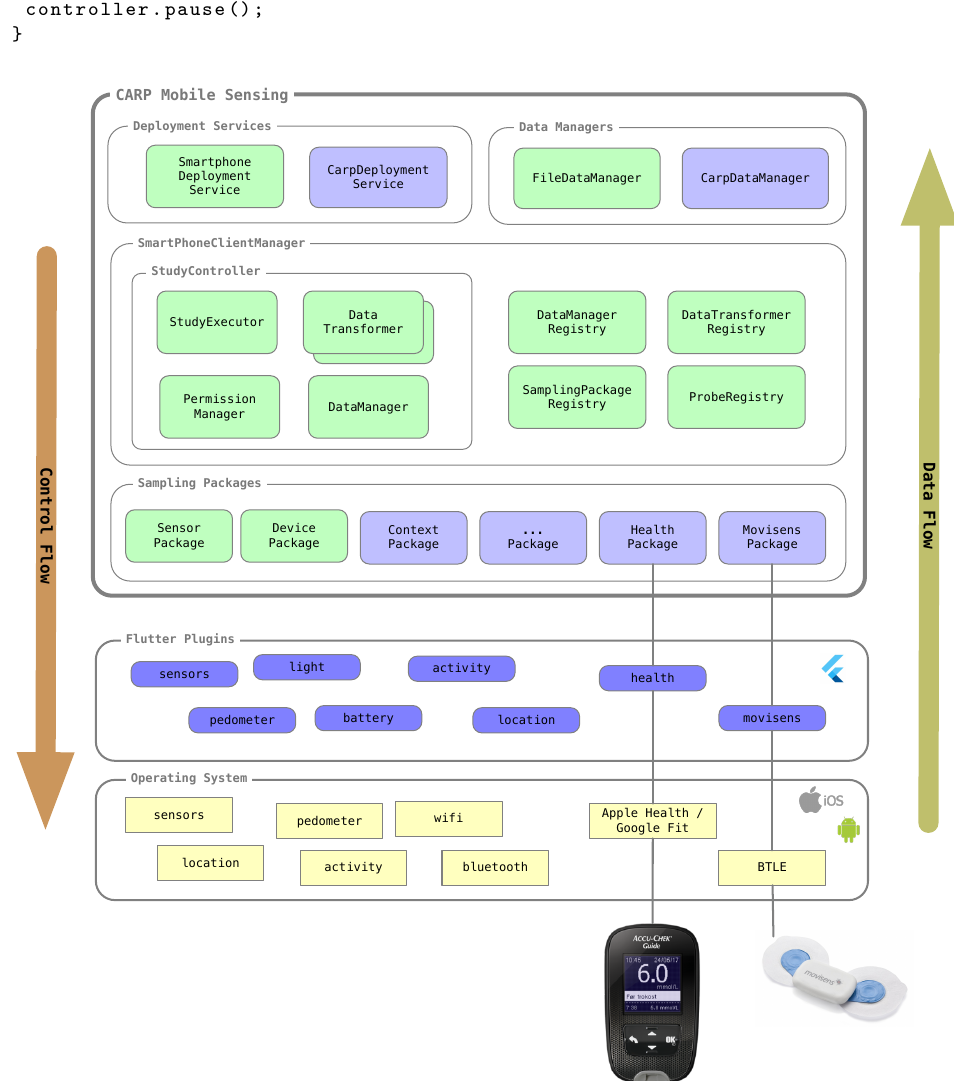
Figure 7. The overall software architecture and main components of the CARP Mobile Sensing (CAMS) framework. CAMS consists of three main layers; sampling packages, client manager, and services. Each sampling package uses one or more Flutter Plugins, which access processes, services, and data in the native OS or from external wearable devices (such as the AccuCheck Guide Blood Glucose Monitor (BGM) or the Movisens ECG devices). Sampling is controlled from the client manager and down to the OS whereas data flow from OS sensors, services, and wearable devices up towards the data